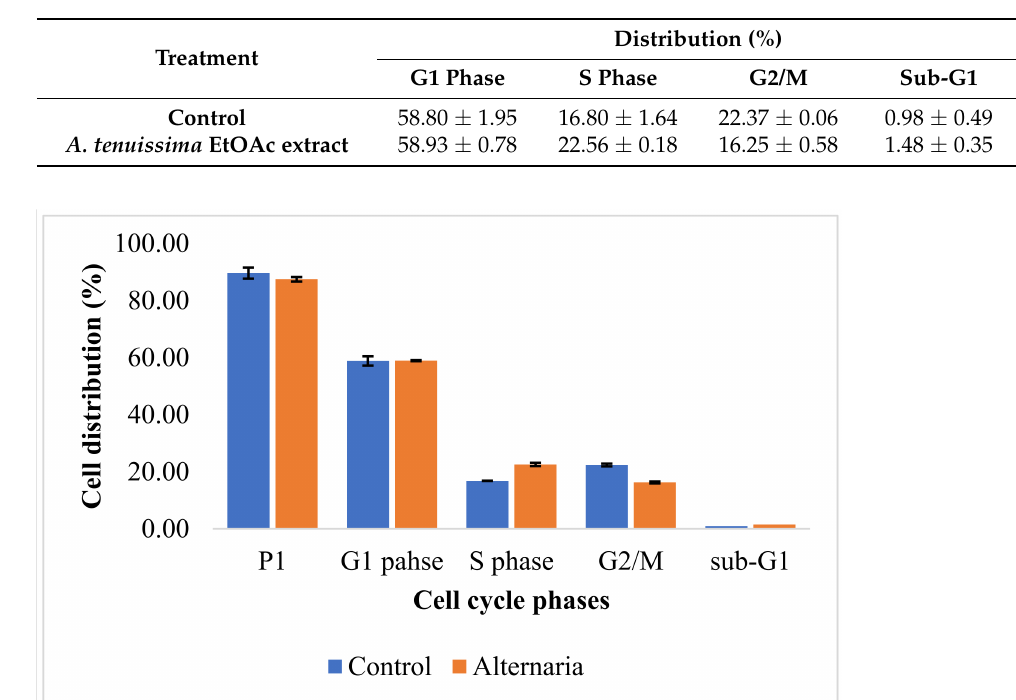
Table 2. Cell cycle distribution of MCF-7 cells.